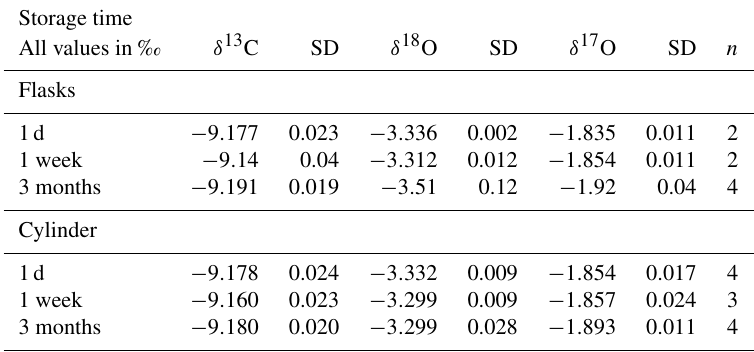
Table 8. Results of isotope measurements of quality control gas from the tank and quality control gas air in flasks (calibrated with the RM) at different periods after the flask filling procedure. The last column shows the number of cylinder measurements or the number of flasks that were used to calculate the average and the standard deviation.